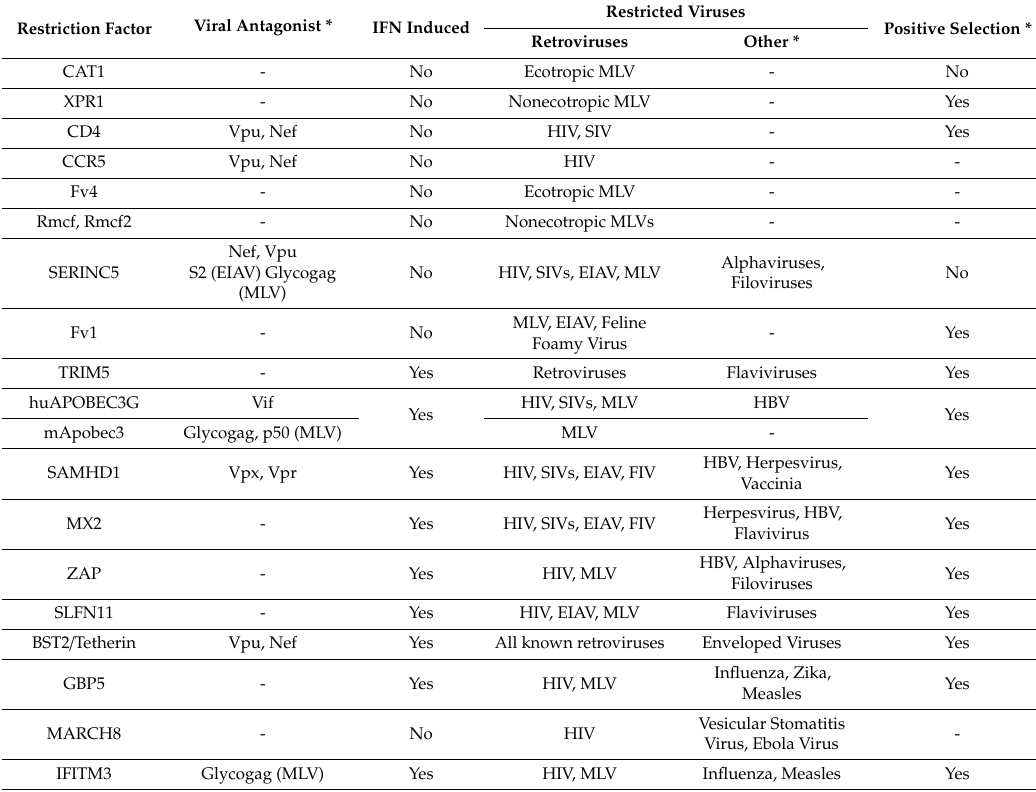
Table 1. Properties of Retroviral Restriction